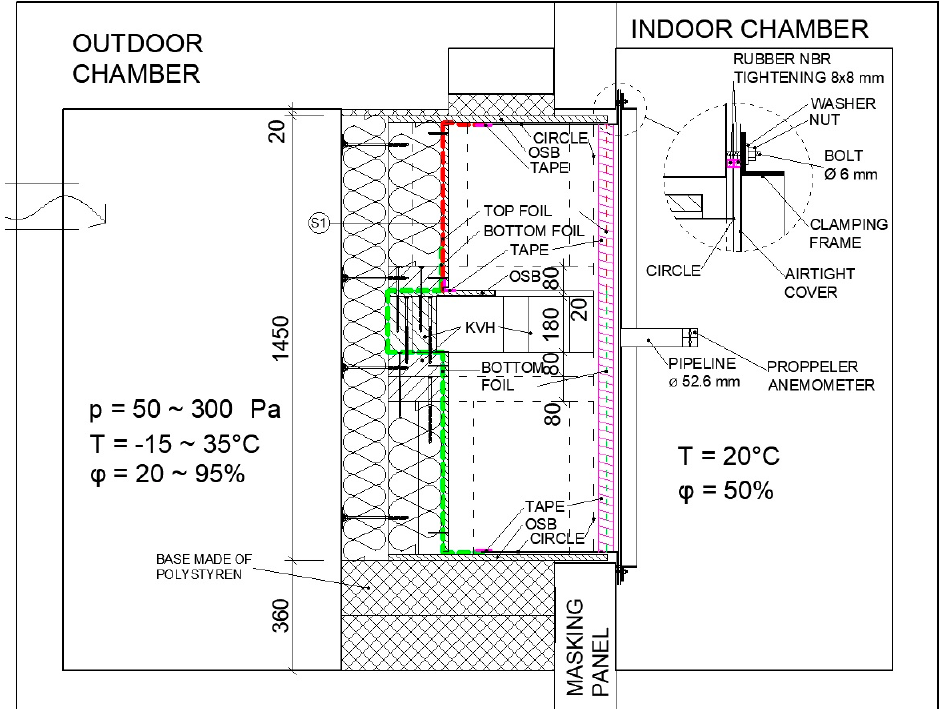
Figure 4. Vertical cross section of the installed specimen.